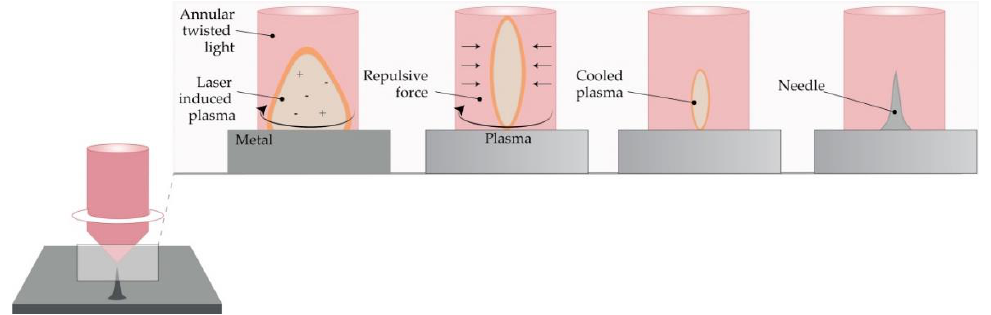
Figure 5. The principle of metal MN fabrication using twisted light with a spin by Omatsu et al. (Modified from [96]).